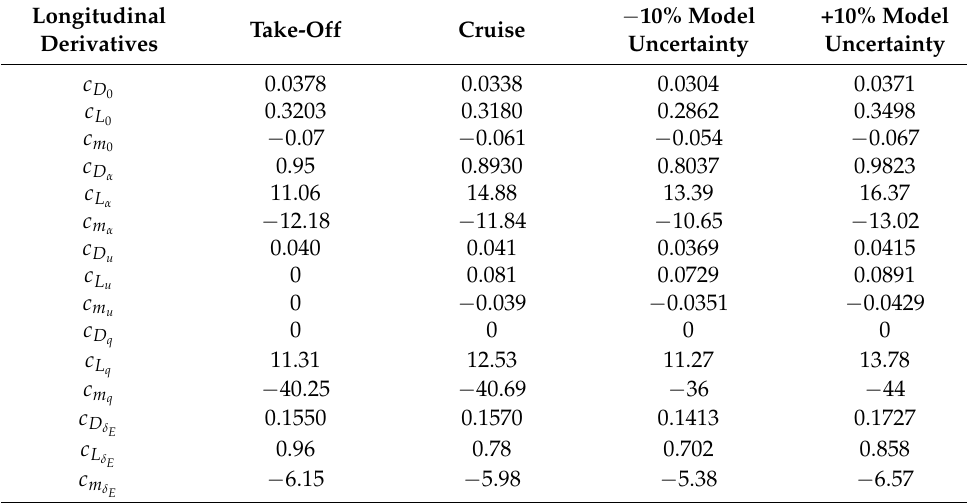
Table 1. Stability and control derivatives (1/rad).